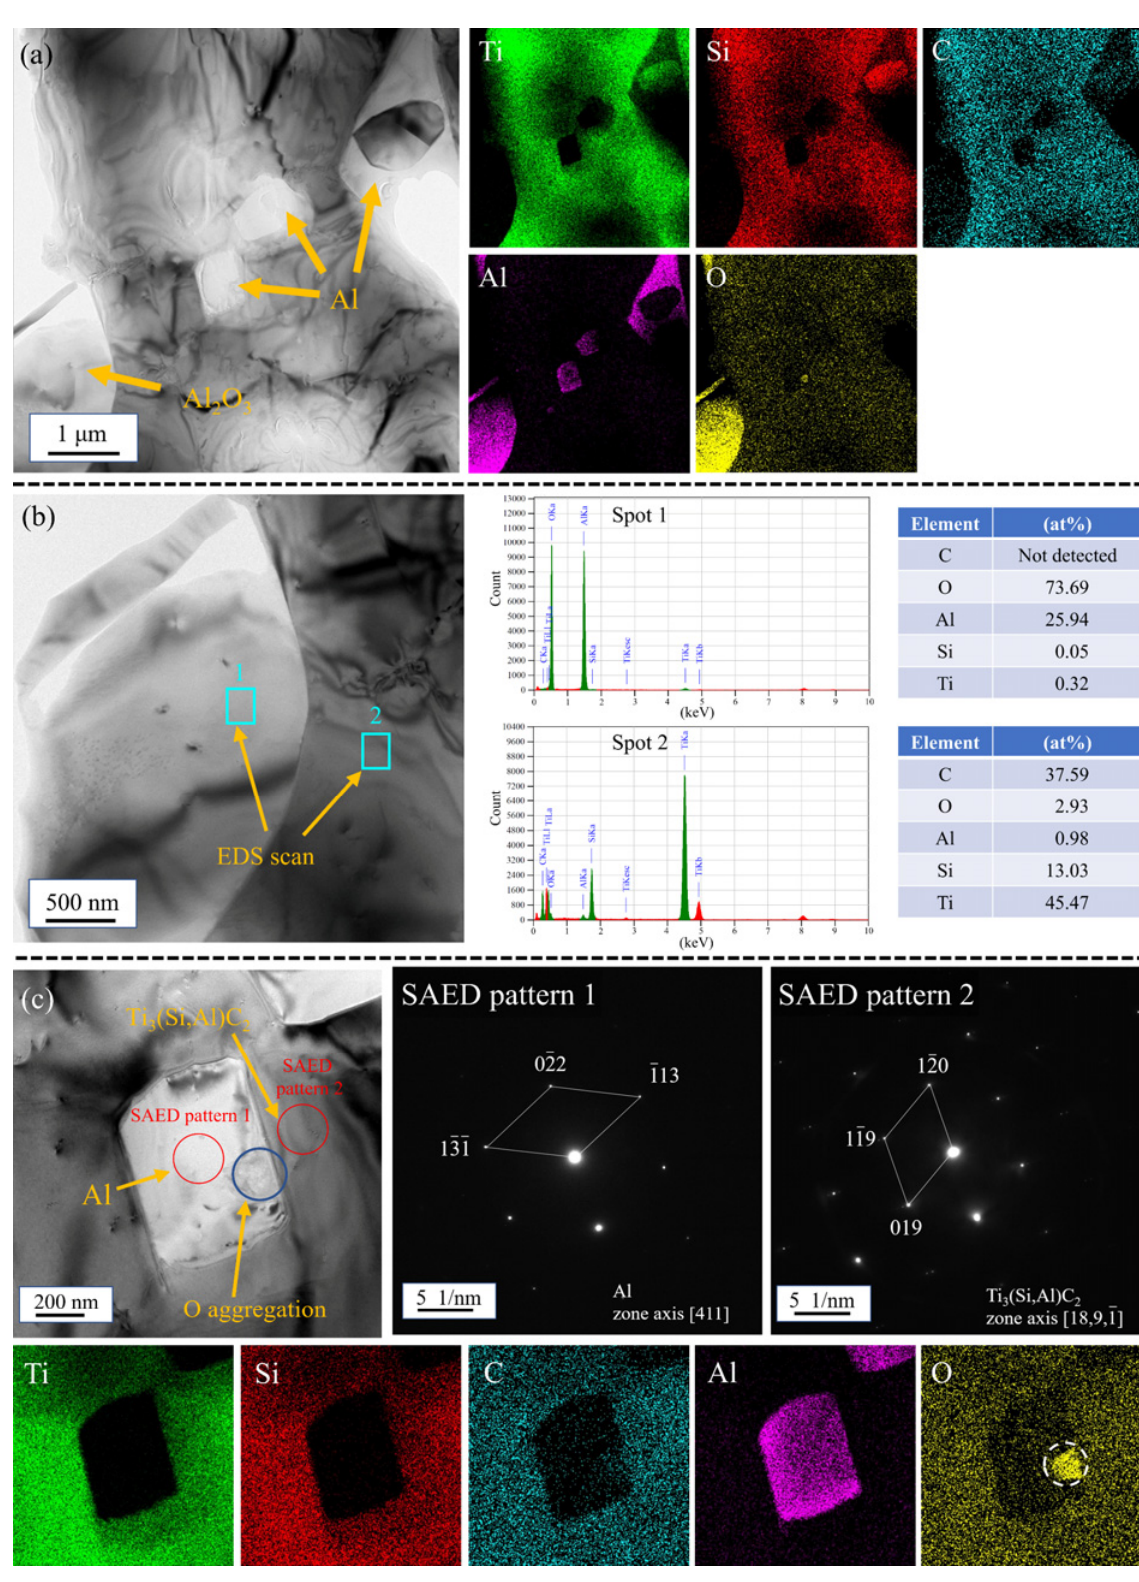
Fig. 7 TEM images of the sintered CAS sample: (a) microstructure of the sintered composite and corresponding elemental distributions; (b) EDS point scan results around the interface between Ti 3 (Si,Al)C 2 and Al 2 O 3 ; and (c) SAED patterns of pure Al and Ti 3 (Si,Al)C 2 in the composite and corresponding elemental